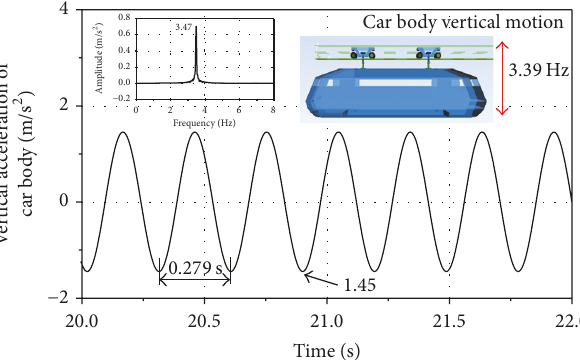
Figure 10: Vertical acceleration of car body at the speed of 21km/h.